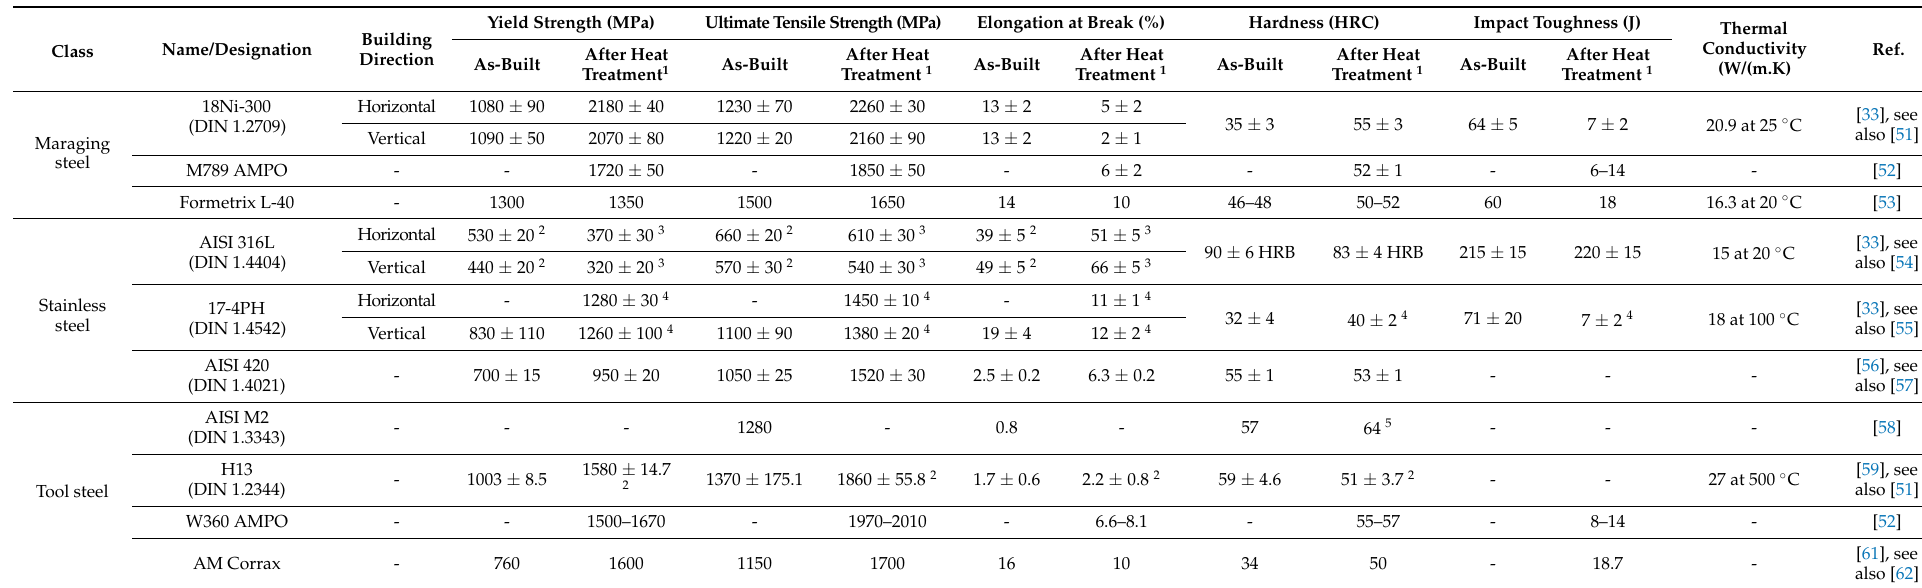
Table 7. The properties of the tools made by additive manufacturing through L-PBF in the powder steels shown in Table